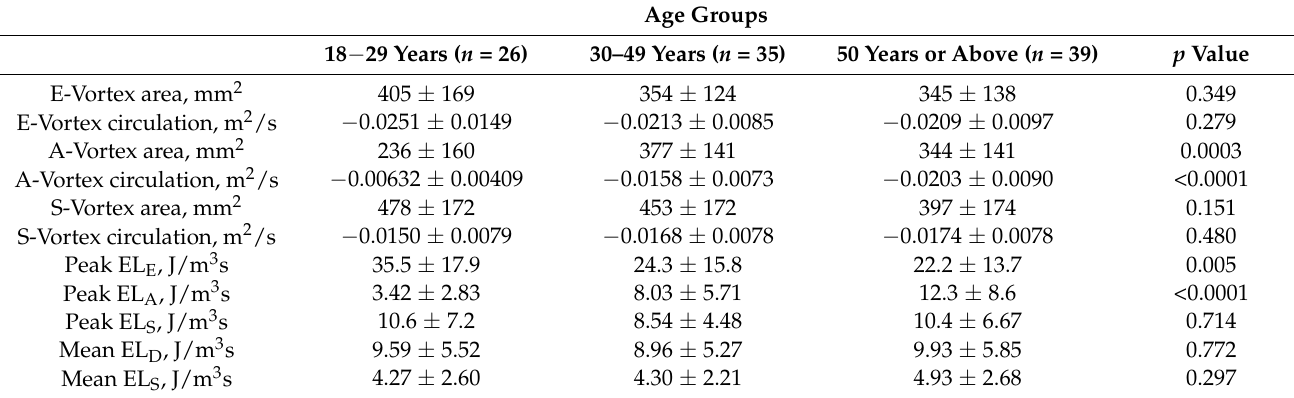
Figure 2. Curve showing intracardiac energy loss by VFM analysis in a young subject. Table 2. Comparison of vector flow mapping results by age